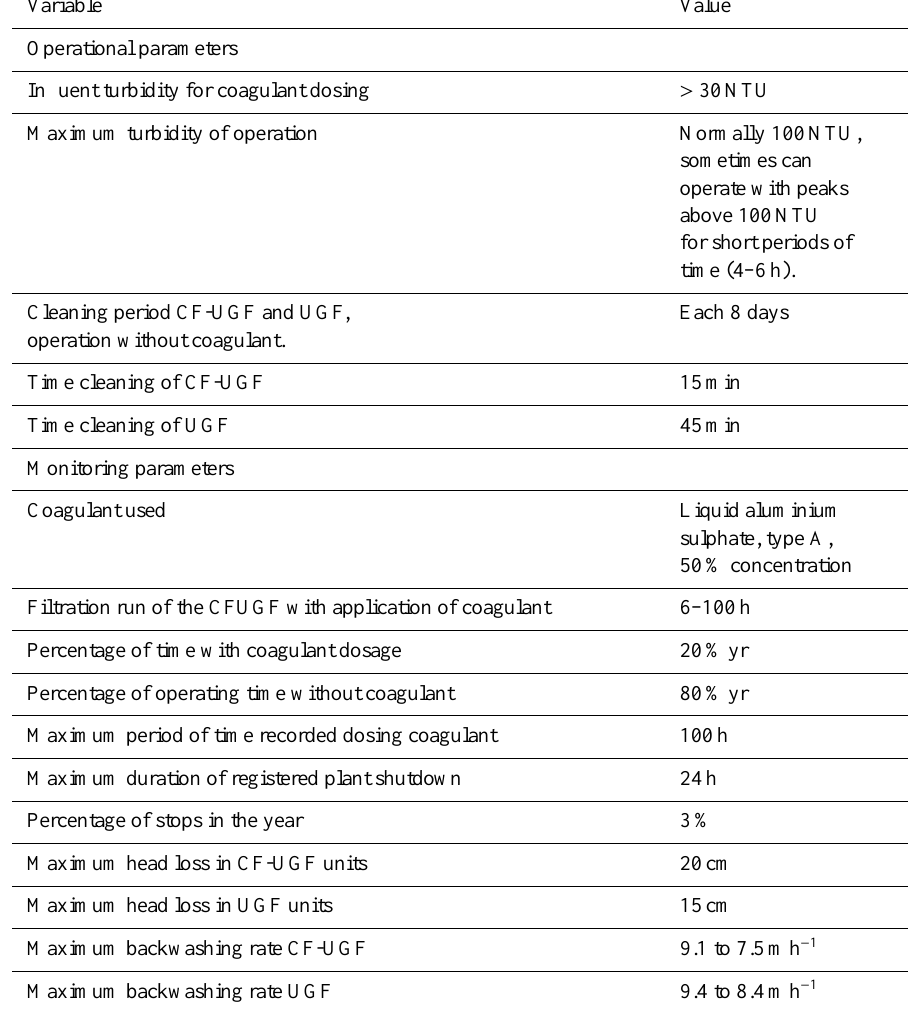
Table 8. Summary of operating and monitoring